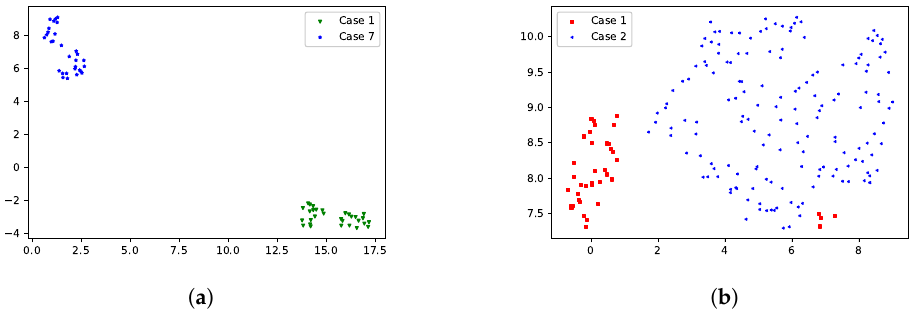
Figure 10. Low-dimensional representation of binary classification for both datasets: ( a ) Dataset 1: Case 1 (Green), Case 7 (Blue); ( b ) Dataset 2: Case 1 (Red), Case 2